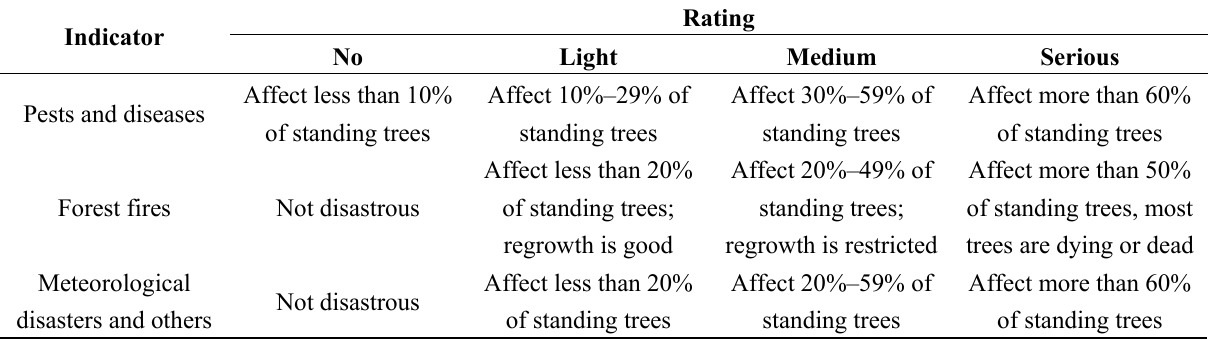
Table 2. Indicators and ratings for evaluating the impact of forest health hazards in China